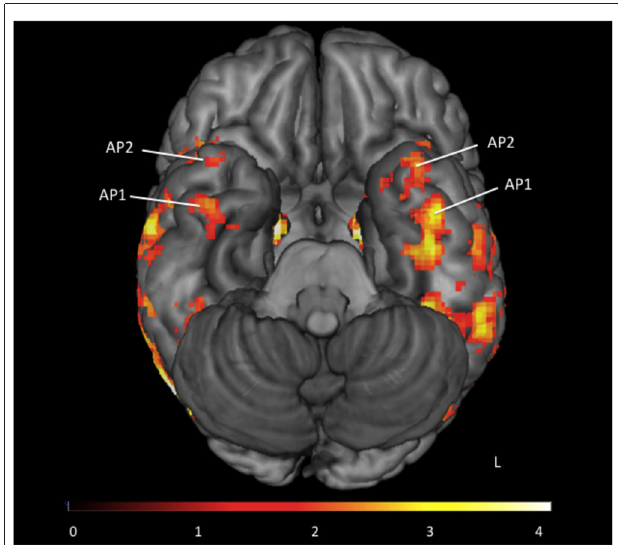
FIGURE 2 | Group map of anterior face temporal face areas. Average activations for the contrast faces > places (thresholded z > 1.65) superimposed on a ventral view of the inferior surface of the brain. Anterior temporal faces areas 1 and 2 are labeled as first anterior temporal face area (AP1) and second anterior temporal face area (AP2) respectively. Color scale presented as z